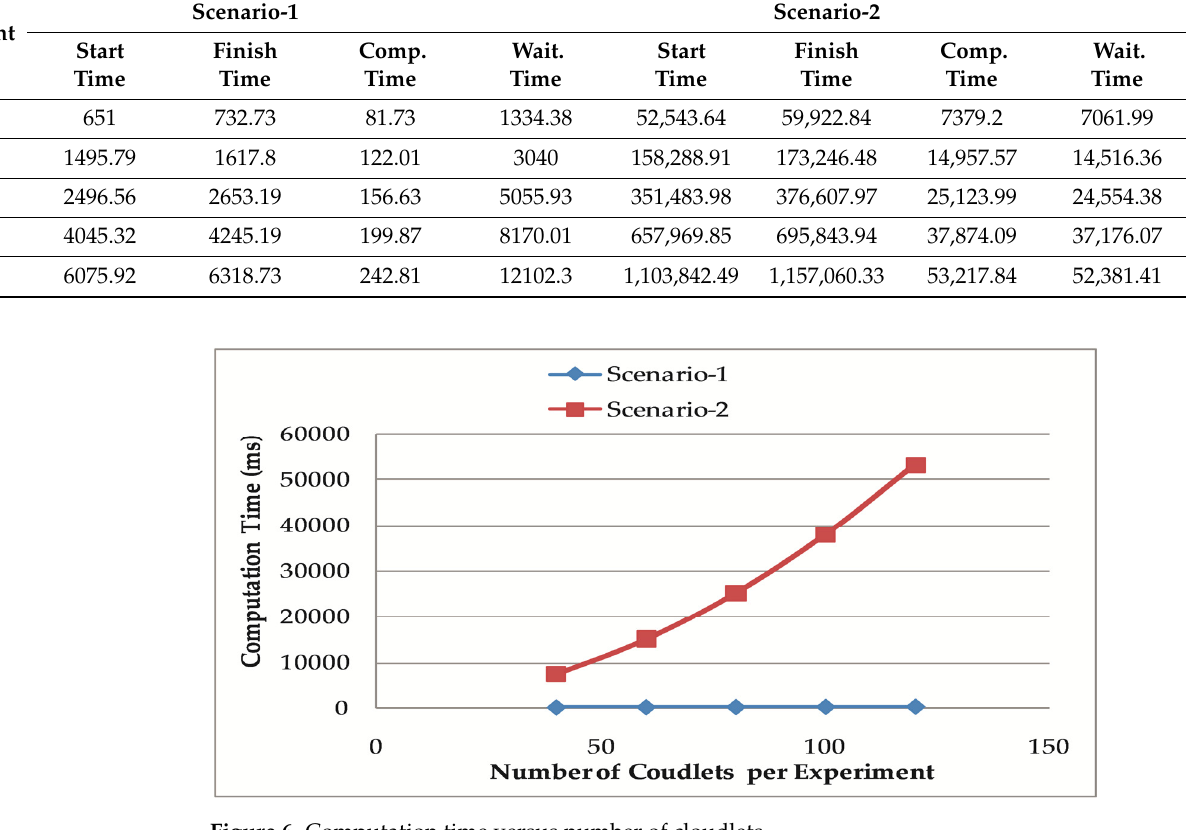
Figure 6. Computation time versus number of cloudlets.